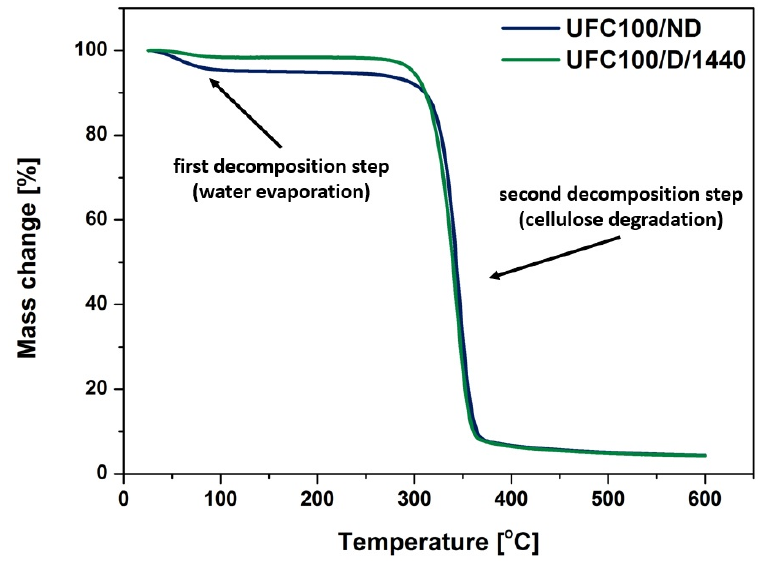
Figure 5. Thermogravimetric analysis (TGA) curves of the dried (1440 min, 100 °C) and not-dried cellulose fibers.